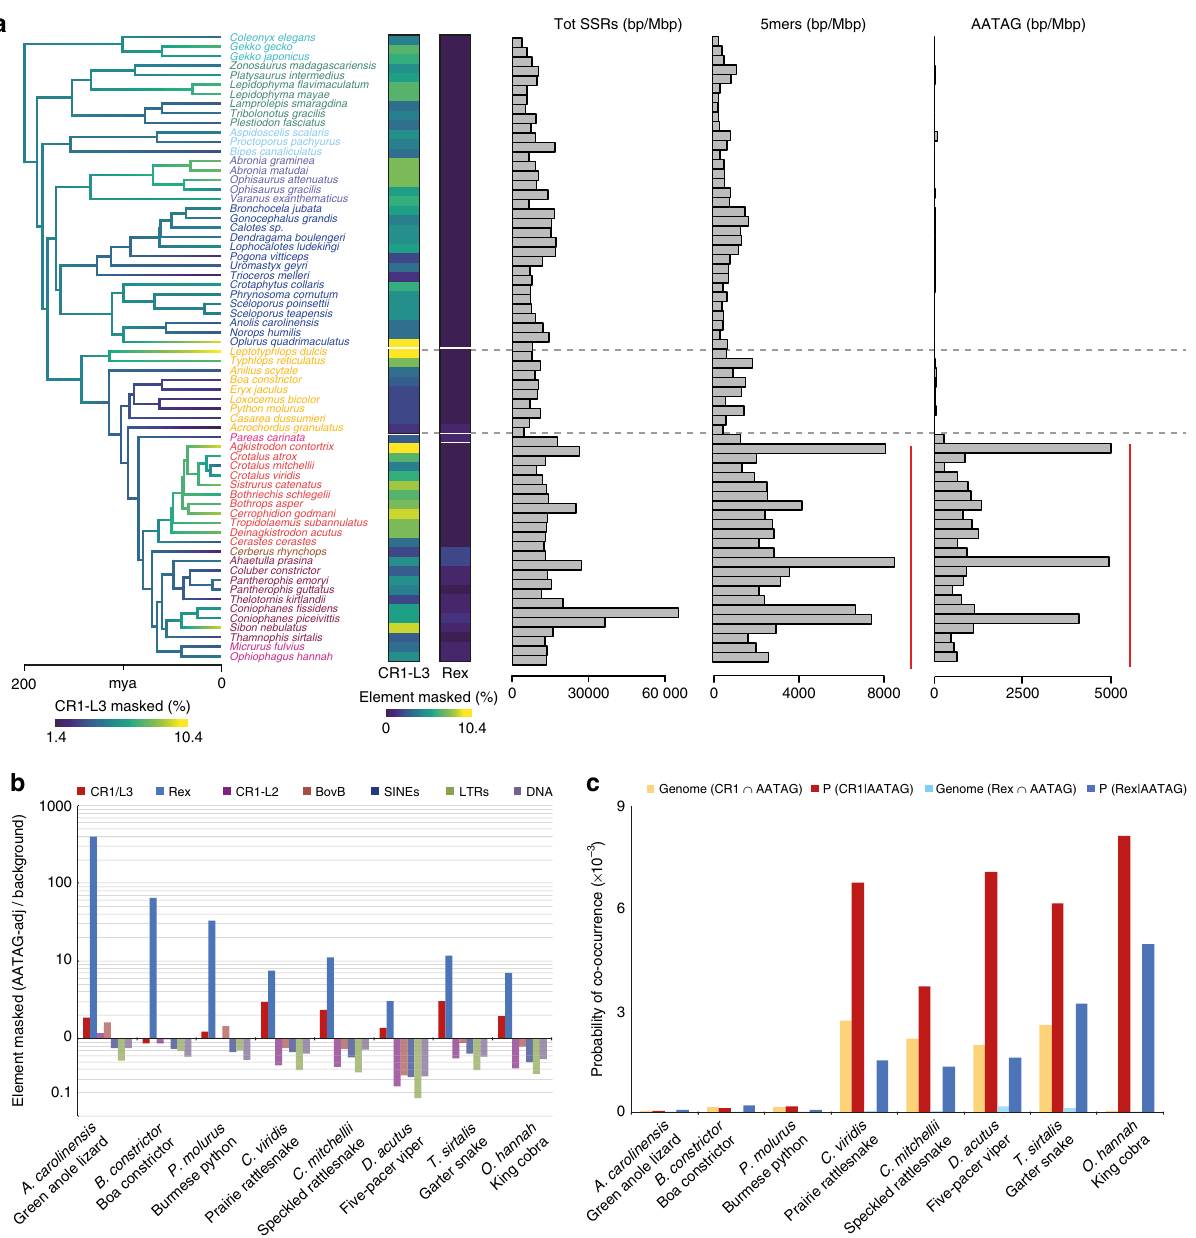
Fig. 2 Microsatellite seeding by transposable elements (TEs) in squamate reptiles. a Branches on the time-calibrated consensus phylogeny are colored according to estimated rates of genomic CR1-L3 LINE evolution. Heat maps show the total genomic content (%) of LINE retrotransposon types involved in microsatellite seeding. Associated bar plots represent the total (left), 5mer (middle), and AATAG (right) microsatellite bp/Mbp density frequencies for each genome sampled. Red lines to the right of the bar plots highlight pronounced seeding of 5mer and AATAG microsatellites in colubroid snakes. b The ratio between TE mapping at the 5 ′ tail of AATAG microsatellite loci (AATAG-adjacent) and TE content averaged over fi ve independent, randomly simulated genomic backgrounds for each class of TEs (SINEs; CR1-L3, Rex, CR1-L2 and BovB LINEs; LTRs; and DNA transposons). Ratios are plotted on a log scale to highlight enriched elements fl anking AATAG loci (ratio >1) in contrast to elements more abundant in the genomic background (ratio <1). c Histogram shows joint and conditional probabilities of associations between AATAG loci and CR1-L3 and Rex. Genomic joint probabilities are shown in orange and light blue for CR1-L3 and Rex, respectively. AATAG-adjacent conditional probabilities are shown in red and dark blue for CR1-L3 and